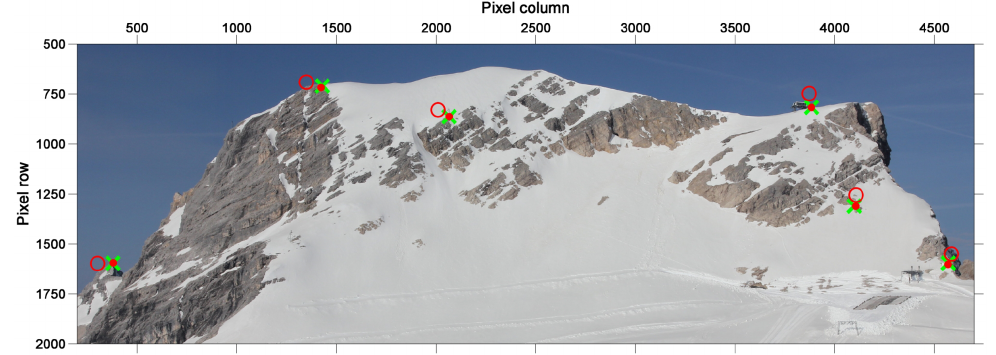
Fig. 7. The correct GCP positions are depicted as green crosses in the enlarged view of the photograph. The georectification using x 0 is shown by the red circles while the red dots illustrate the georectification after the DDS optimisation ( m = 3000) using x best .